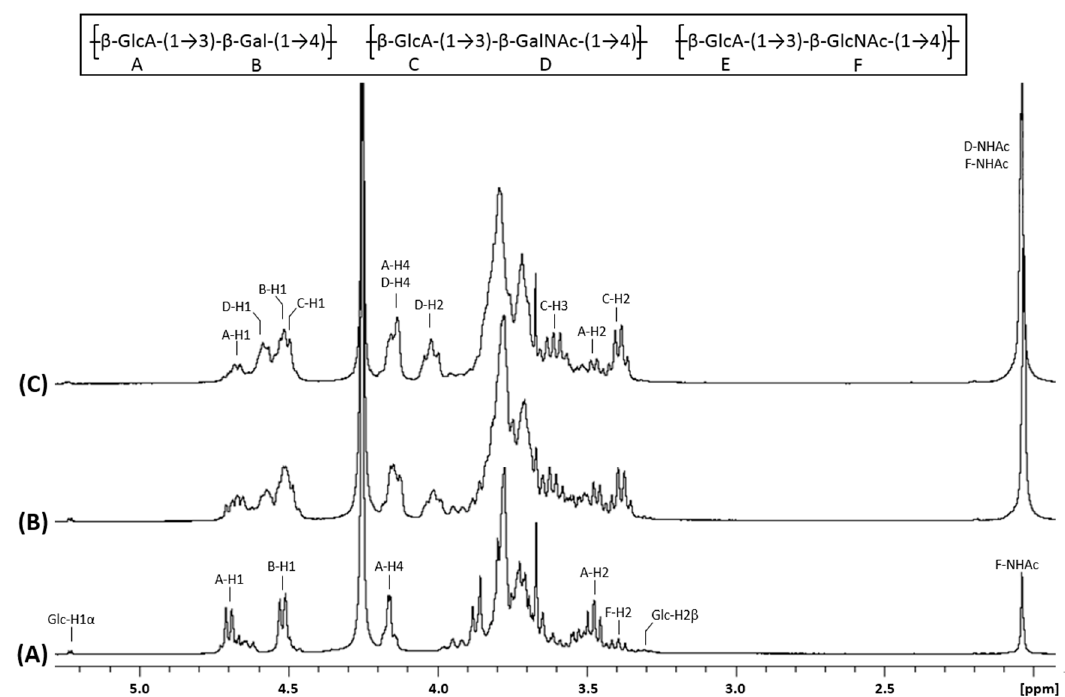
Figure 3. 1 H NMR spectra of chondbiuronan ( A ) and chondroitin obtained using 0.5% ( B ) and 2% ( C ) arabinose induction. Inset: chemical structure of the polysaccharides.